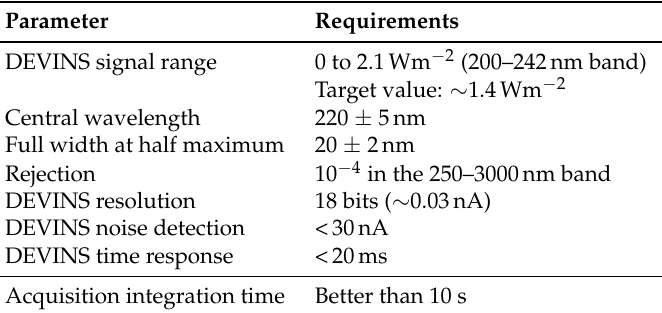
Table 6. DEVINS photodiodes’ technical requirements.